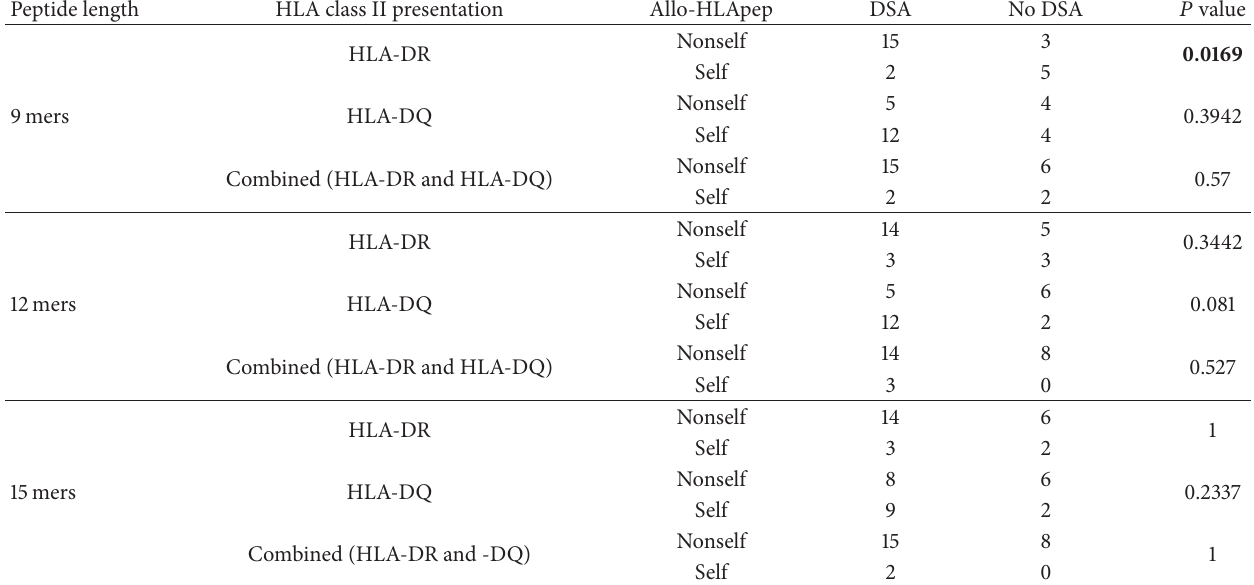
Table 5: Association between the nature (self or nonself) of the peptide predicted to bind with highest affinity to the recipient’s HLA-II antigens and the presence of